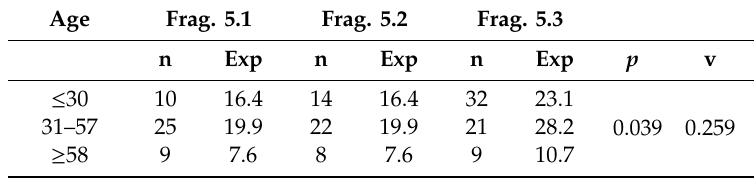
Table 8. Association between age and